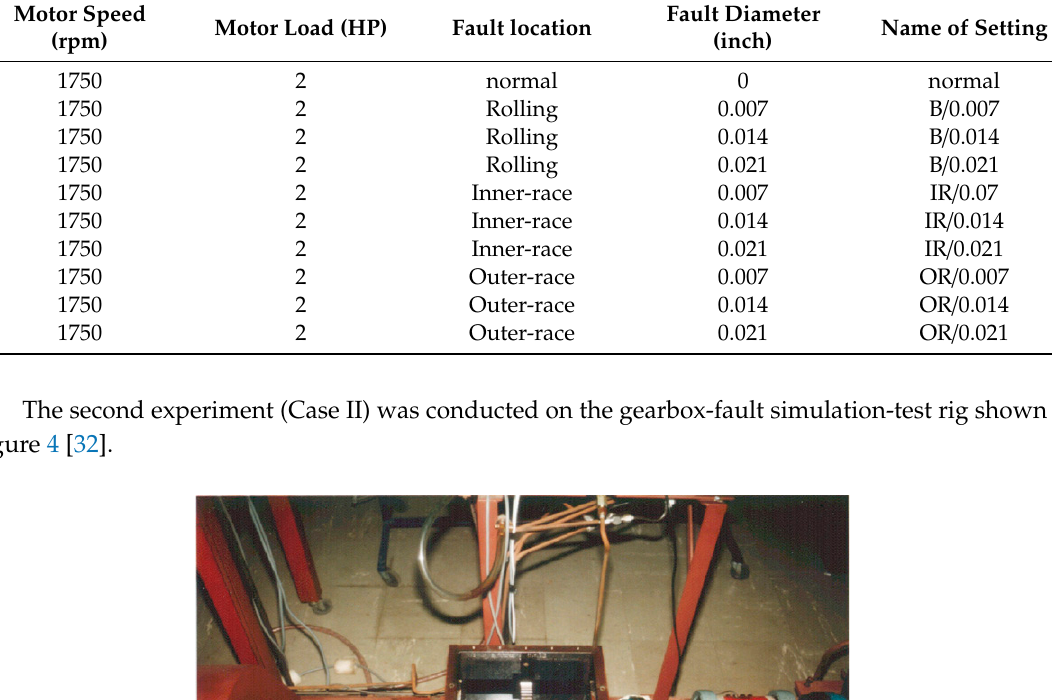
Table 2. Description of dataset in case I.